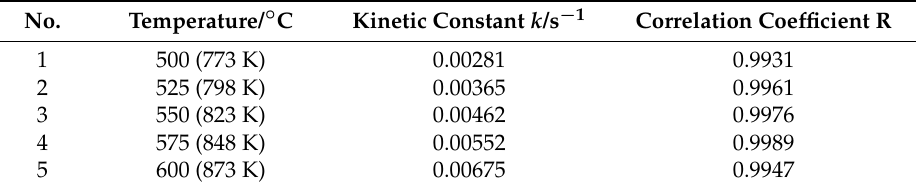
Figure 7. Linear fitting of the function ln[ − ln(1 − α )] 1/1.58 vs. t for the selected process temperatures. Table 3. Kinetic constant ( k ) values for the selected process temperatures studied.